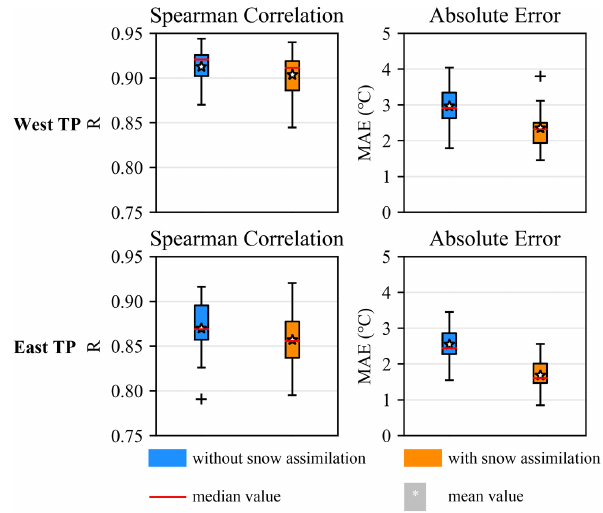
Figure 7. The Spearman’s correlation coefficient and mean absolute error in daily temperature between the two ensemble reforecasts and CN05.1